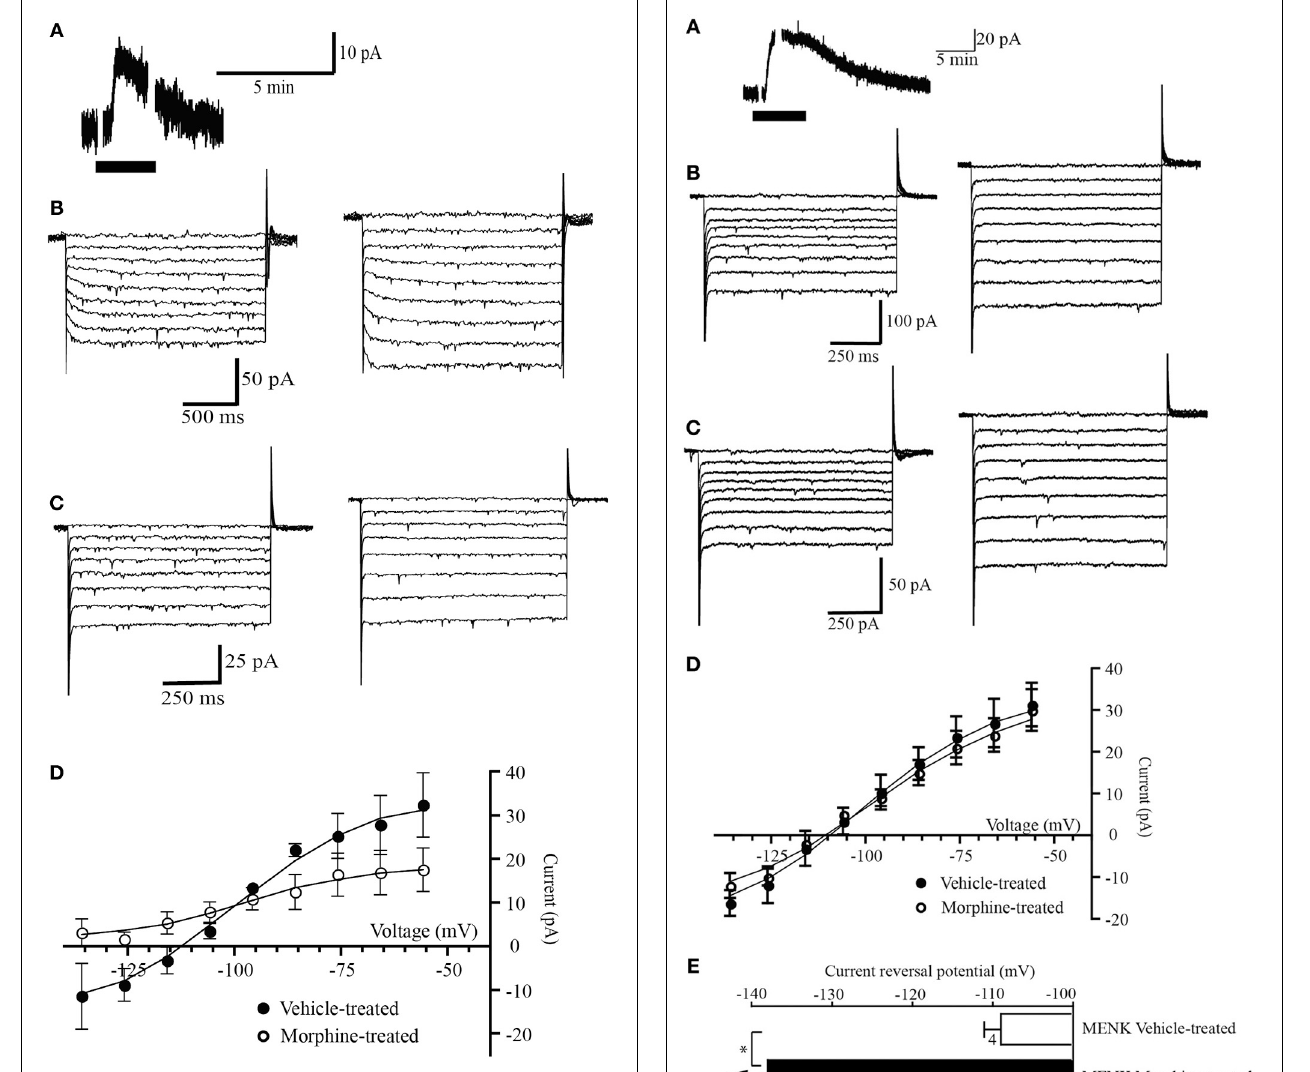
FIGURE 1 | Opioid receptors simultaneously couple to a potassium conductance and a GAT-1 conductance. (A) Example trace of currents from a neuron voltage clamped at − 56mV (drug superfusion shown by bars). MENK (30 μ M) induced an outward current in neuron from a morphine-treated mouse. (B,C) Currents produced by voltage steps from − 56mV to − 136mV in − 10mV increments in a neuron from (B) a vehicle-treated mouse and (C) a morphine-treated mouse before (left) and during MENK (30 μ M) application (right). (D) Subtracted current-voltage relationships for MENK (current in MENK—current during control conditions). Reversal potentials were determined at the point where they cross the abscissa. The MENK current reversed polarity near E K in neurons from vehicle-treated ( n = 4 ), but not in neurons from morphine-treated mice ( n = 5 ).